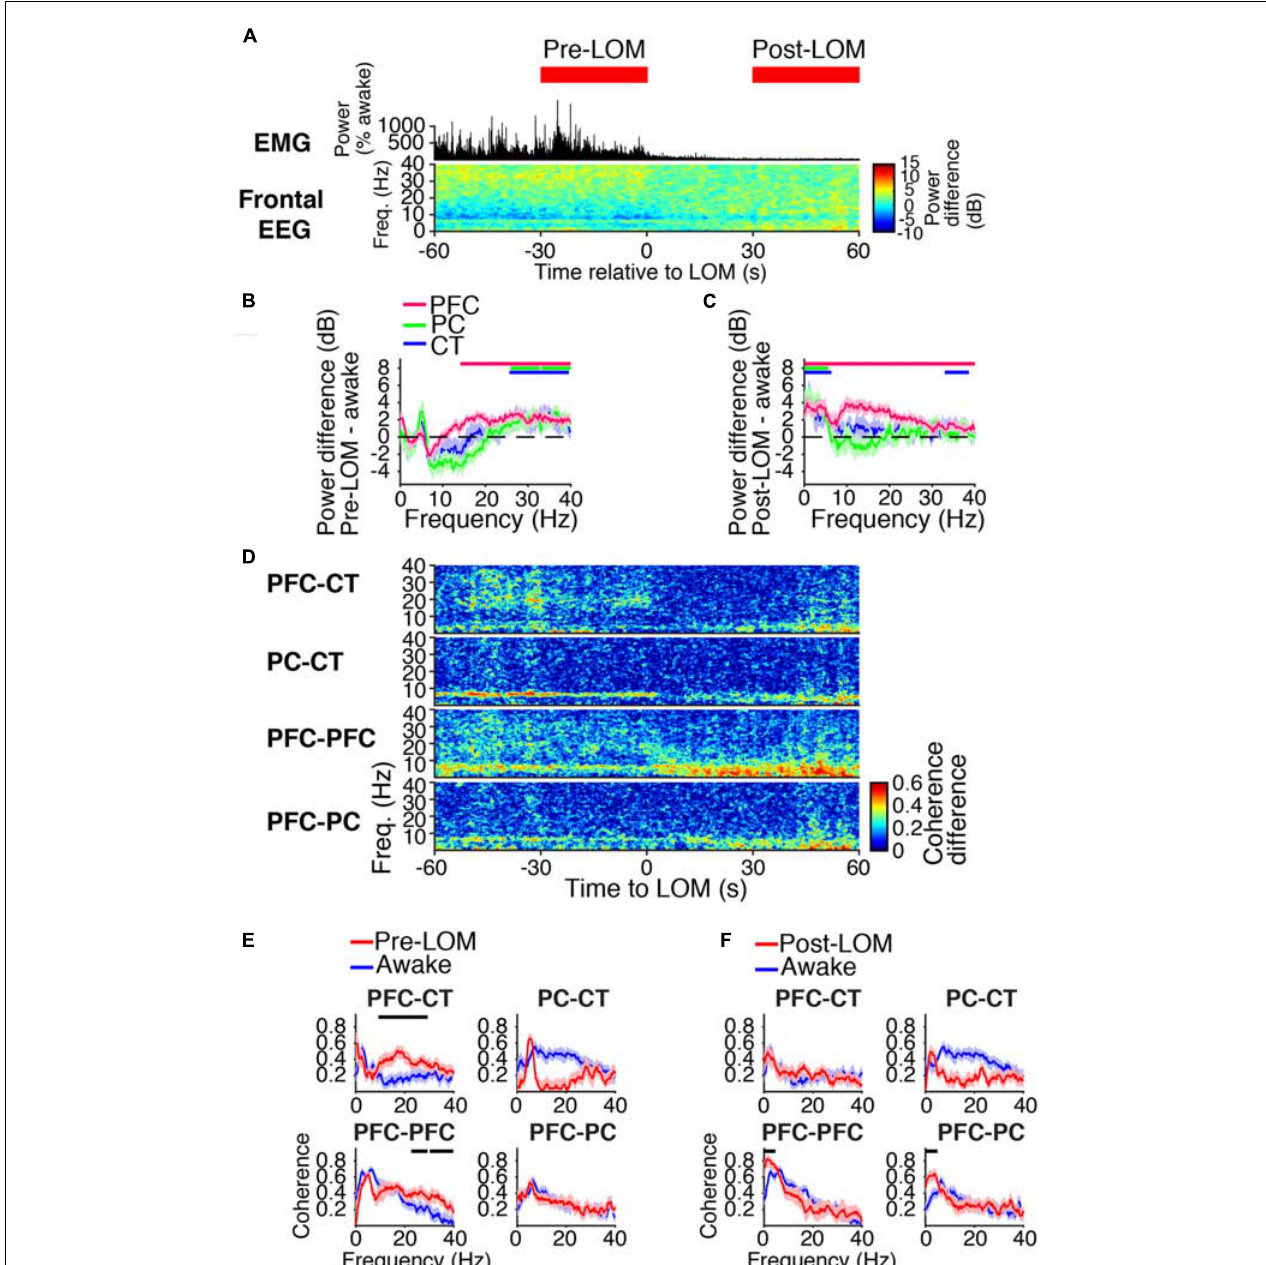
FIGURE 4 | Dynamics around the time of loss of movement. (A) Group EMG power and group difference spectrogram of the frontal EEG aligned to LOM. Red rectangles mark the periods analyzed in (B,C,E,F) . (B,C) Group power difference between 30-s periods immediately before (B) or 30 s after (C) LOM and awake baseline for PFC (red), PC (green), and CT (blue) LFPs. Shading indicates 95% confidence intervals. Red, green, and blue horizontal lines mark ranges of significant power increase relative to awake baseline for PFC, PC, and CT LFPs, respectively. (D) Group difference coherograms for pairs of LFPs aligned to LOM. (E,F) Group coherence during awake baseline (blue) and periods before (E) or after (F) LOM (red). Shading indicates 95% confidence intervals, and horizontal lines mark ranges of significant coherence increase from awake baseline.